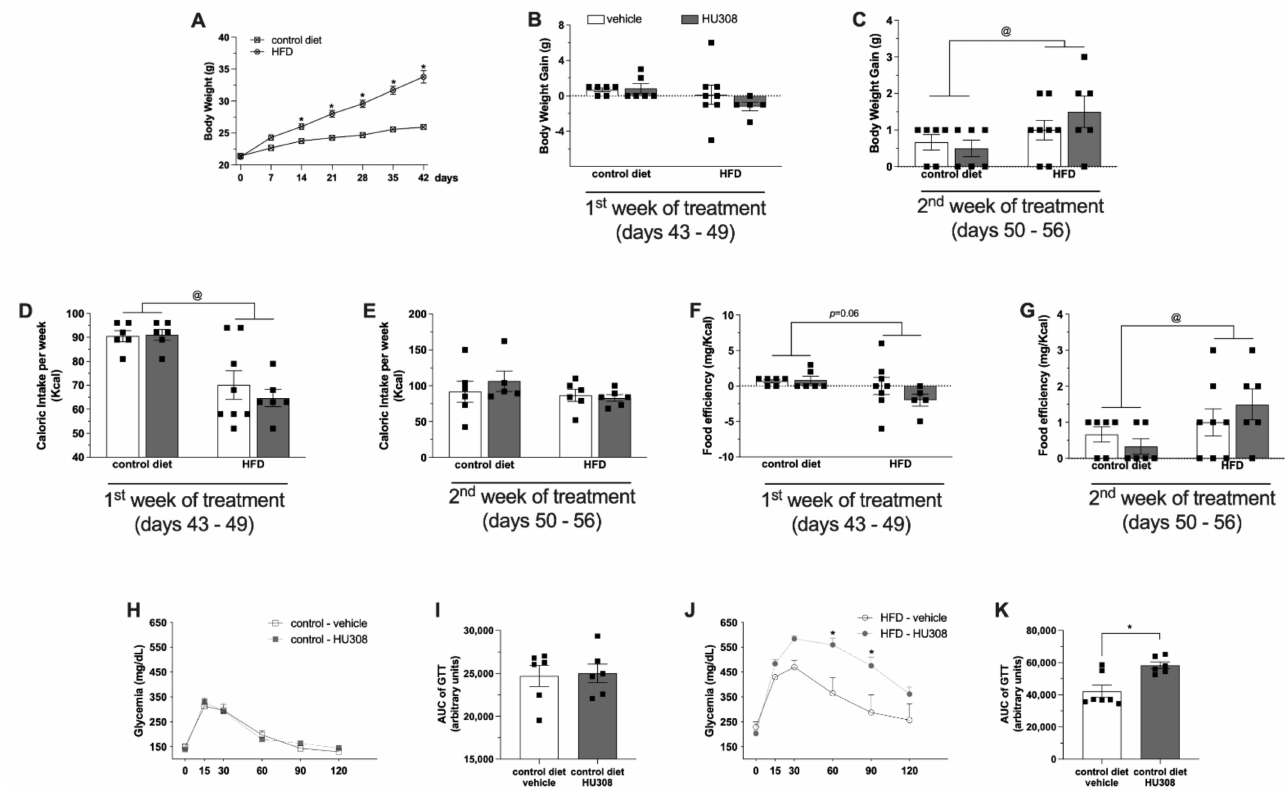
Figure 1. Effect of prolonged icv infusion of vehicle or HU308 for 2 weeks on the body weight, caloric intake, food efficiency ratio and GTT in animals fed a control diet or high-fat diet (HFD). Body weight curve in control diet-fed or HFD-fed animals before surgical procedure ( A ). The body weight gain (g) ( B , C ), caloric intake (Kcal) ( D , E ) and food efficiency (mg/Kcal) ( F , G ) after 1 or 2 weeks of icv vehicle or HU308 infusion in control diet-fed or HFD-fed animals. Plasma glucose levels (mg/dL) after glucose overload in control diet-fed ( H ) or HFD-fed ( J ) animals during prolonged infusion of vehicle or AM630. AUG of GTT in control diet-fed ( I ) or HFD-fed ( K ) animals treated with vehicle or AM630. One sample from HFD + vehicle group in the GTT study were not used because of problems with glucose overload injection. The data are expressed as the mean ± SEM; n = 5–8 per group. Data were analyzed by unpaired t test ( I , K ) or two-way ANOVA followed by Tukey’s ( B – G ) or Š í d á k’s ( H , J ) post-hoc test. @ p < 0.02 (effect of diet), * p = 0.05 (effect of